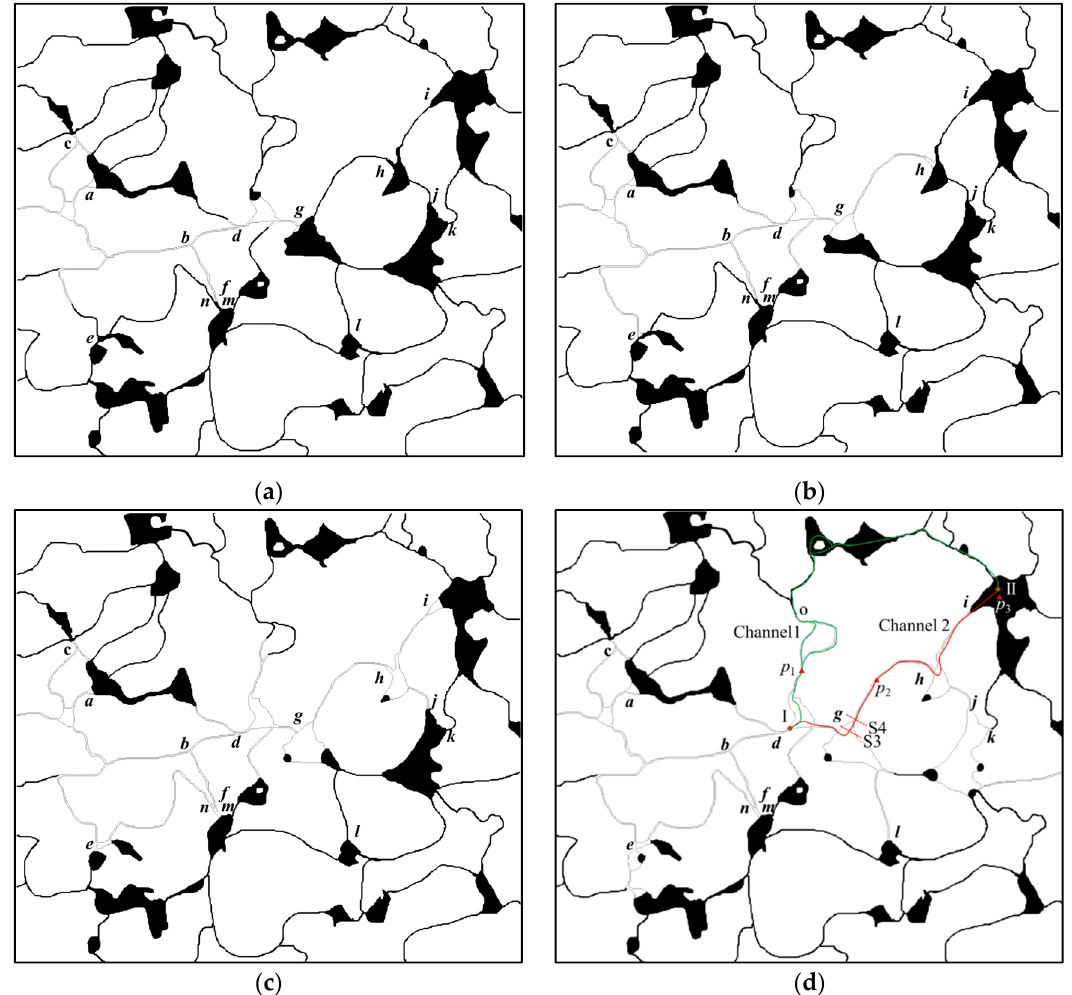
Figure 9. Oil and water distribution at different times, at the injection velocity of 0.01 m · s − 1 (Ca = 1.43 × 10 − 4 ): ( a ) 1.2 s, ( b ) 1.9 s, ( c ) 3.3 s, ( d ) final. Different positions are indicated by lower case letters. Table 3. Blockage and restart information at different locations during the injection process, at the